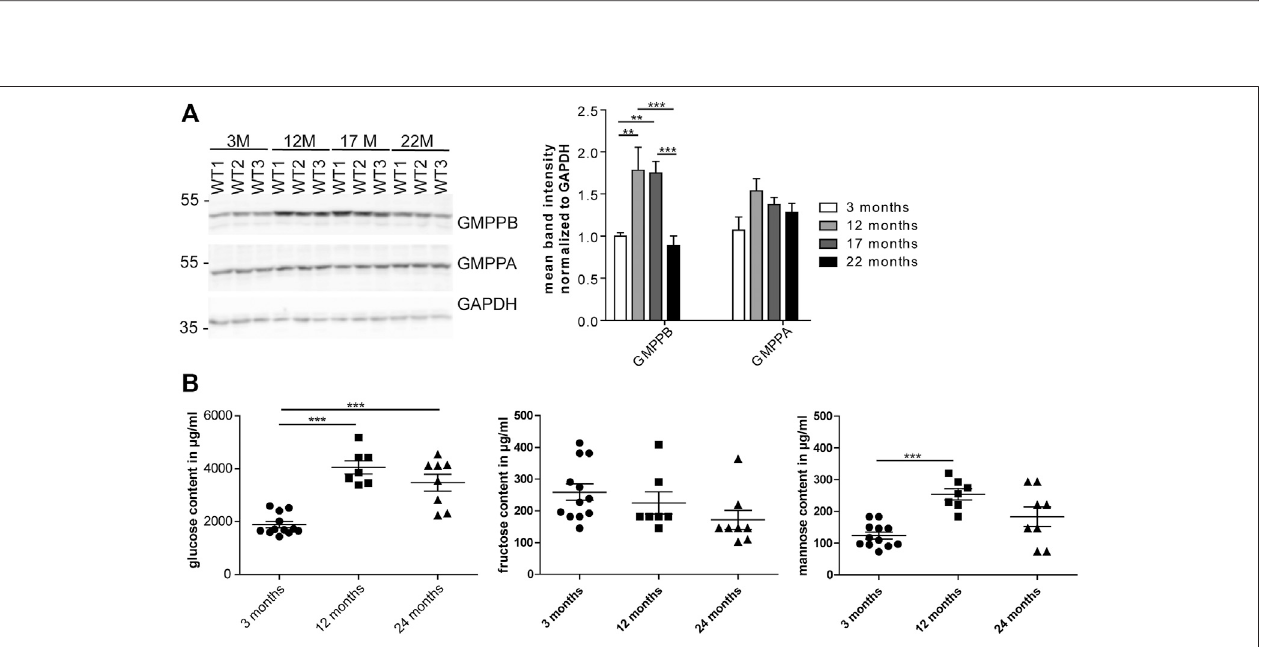
FIGURE 3 | Age-dependent changes in cardiac GMPPB abundance and serum mannose concentrations. (A) GMPPB abundance increases between 3 and 12 months of age, while GMPPA abundance does not change. GAPDH served as loading control ( n (cid:2) 6 mice per age; 2-way ANOVA with Bonferroni posthoc test). (B) Sugar concentrations in serum of non-fasted mice. Glucose and mannose concentration increase between 3 and 12 months of age, while fructose concentration does not change ( n (cid:2) 7 – 12 mice per age; 1-way ANOVA with Bonferroni posthoc test). Data are presented as individual data points with SEM or as mean ± SEM. Individual data points are shown in Supplementary Figure S2 .